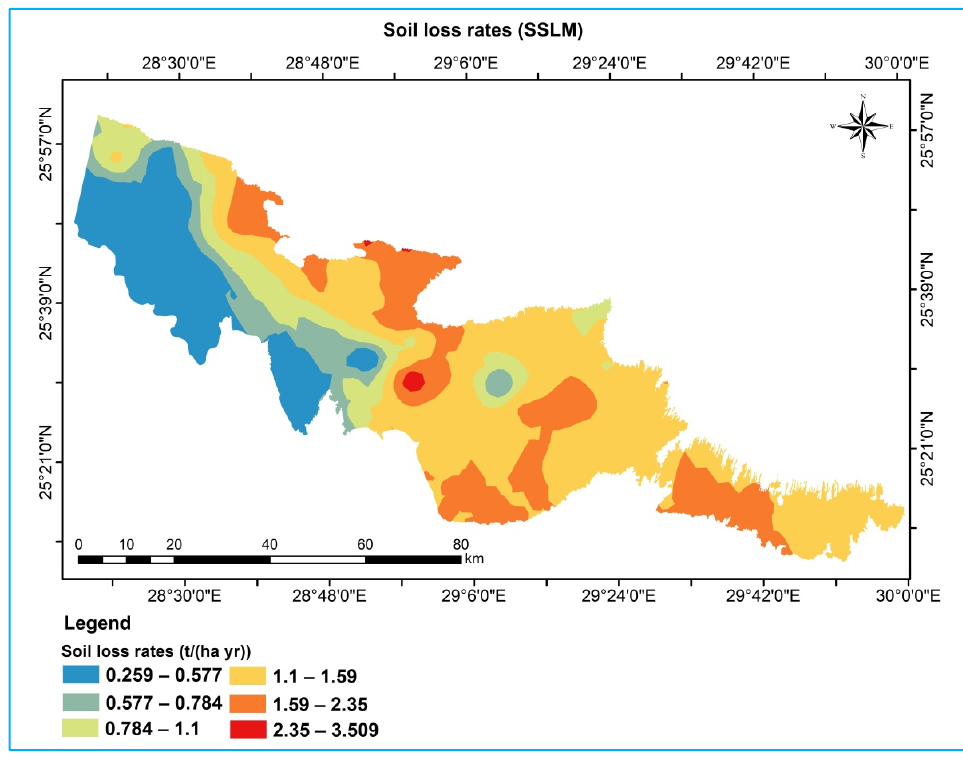
Figure 13. Spatial distribution map of soil loss rates according to the proposed model